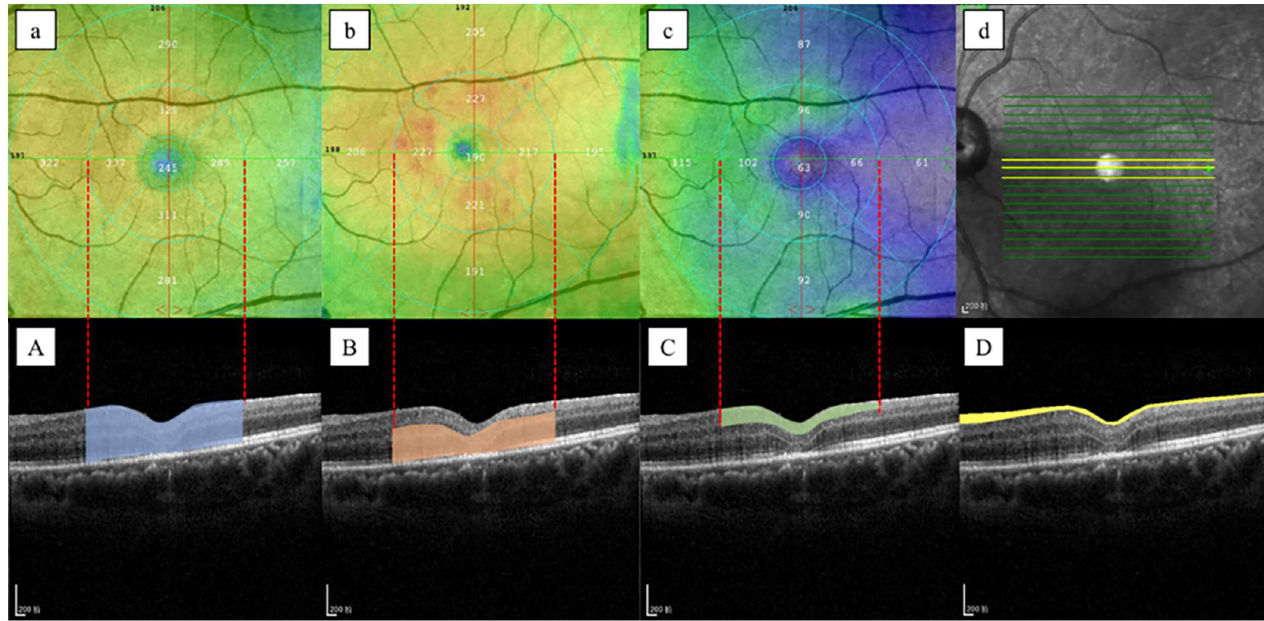
Figure 2. Left eye of a 57-year-old woman treated with vitrectomy and ILM peeling for IMH. ( a – c ). The thickness of TRL, ORL, and IRL in different parafoveal regions was automatically identified using the Early Treatment Diabetic Retinopathy Study (ETDRS) grid and measured by RTVue XR OCT. ( d ). The B-scan OCT images of the fovea, the closest superior to the fovea, and the closest inferior to the fovea were used for the measurement of RNFL cross-sectional area. ( A ). The TRL was defined as the area between the ILM and the RPE as the area shown in blue. ( B ). The ORL was defined as the area from the inner nuclear layer to the RPE as the area shown in orange. ( C ). The IRL was defined as the area from the ILM to the inner plexiform layer as the area shown in green. ( D ). RNFL cross-sectional area (i.e., yellow section) in B-scan OCT images was measured manually using ImageJ software.